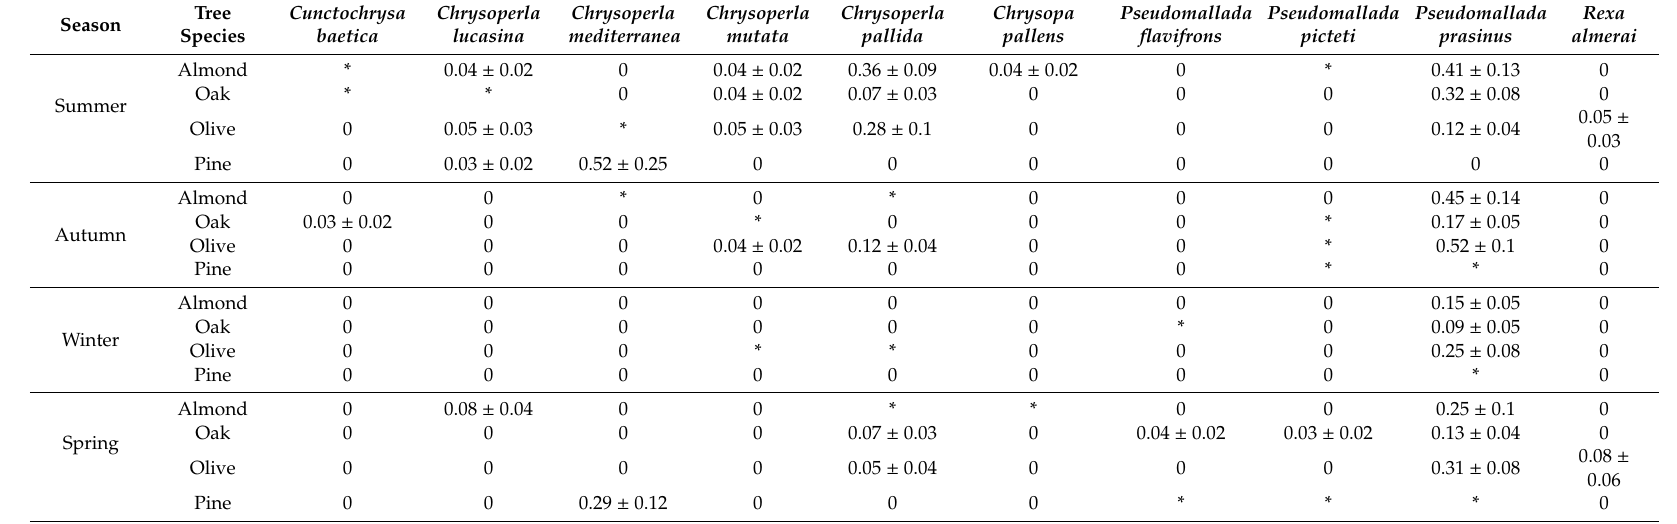
Table 4. Abundance (mean ± SE) of chrysopid species that emerged in laboratory from chrysopid juveniles collected from almond, oak, olive and pine trees by season.